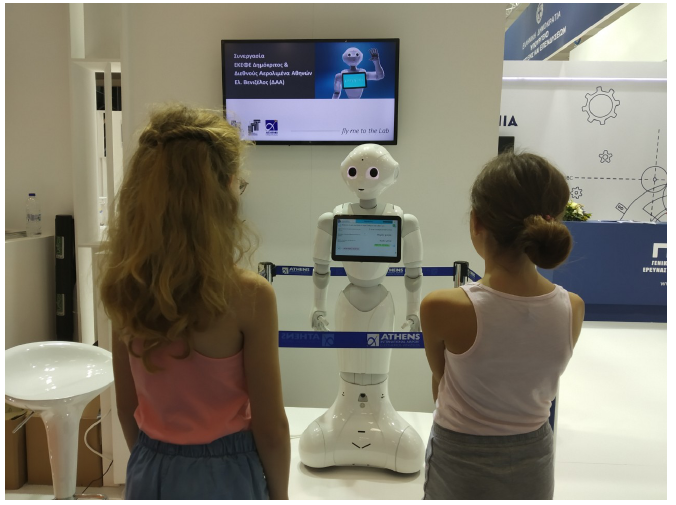
Figure 1. Pepper robot